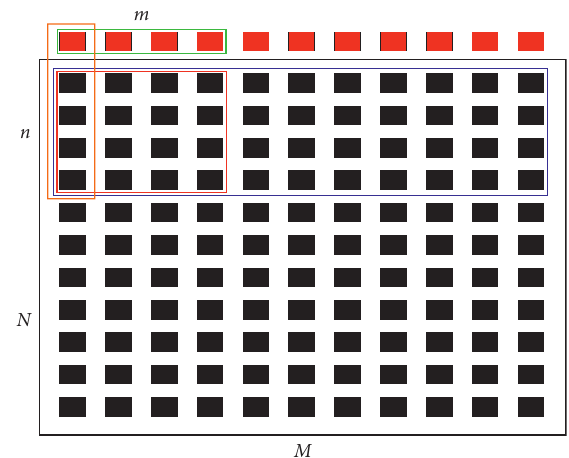
Figure 6: The principle of Box Filter.